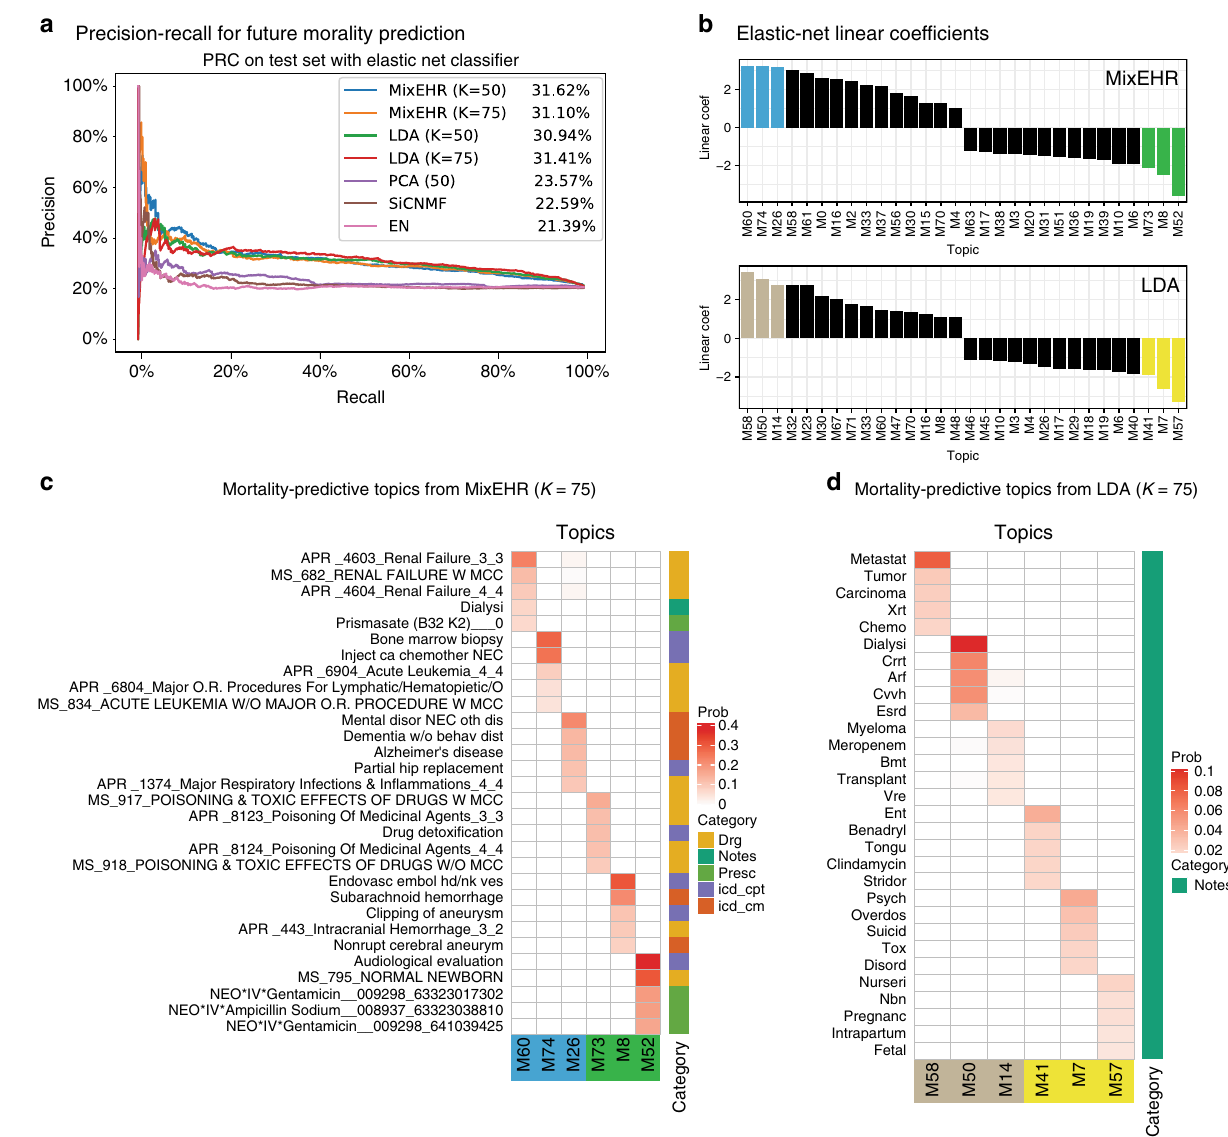
Fig. 8 Mortality prediction using MIMIC-III dataset. Each unsupervised embedding method was trained on the patients with only one admission in the MIMIC-III data. The trained model was then applied to embed the second-last admission from patients with at least two admissions that are within 6 months apart. An elastic net (EN) classi fi er was trained to predict the mortality outcome in the last admission. This was performed in a fi vefold cross- validation setting. a Precision – recall curve (PRC) were generated, and the area under of the PRC (AUPRC) were displayed in the legend for each embedding method. EN represents the performance of elastic net using the raw EHR features. b Linear coef fi cients for the topics from MixEHR and LDA. The top three and bottom three topics are highlighted. c Topic clinical features for the top three most positively predictive topics and three most negatively predictive topics based on the elastic net coef fi cients for the 75 latent disease topics from MixEHR. d Same as c , but for the top predictive topics from